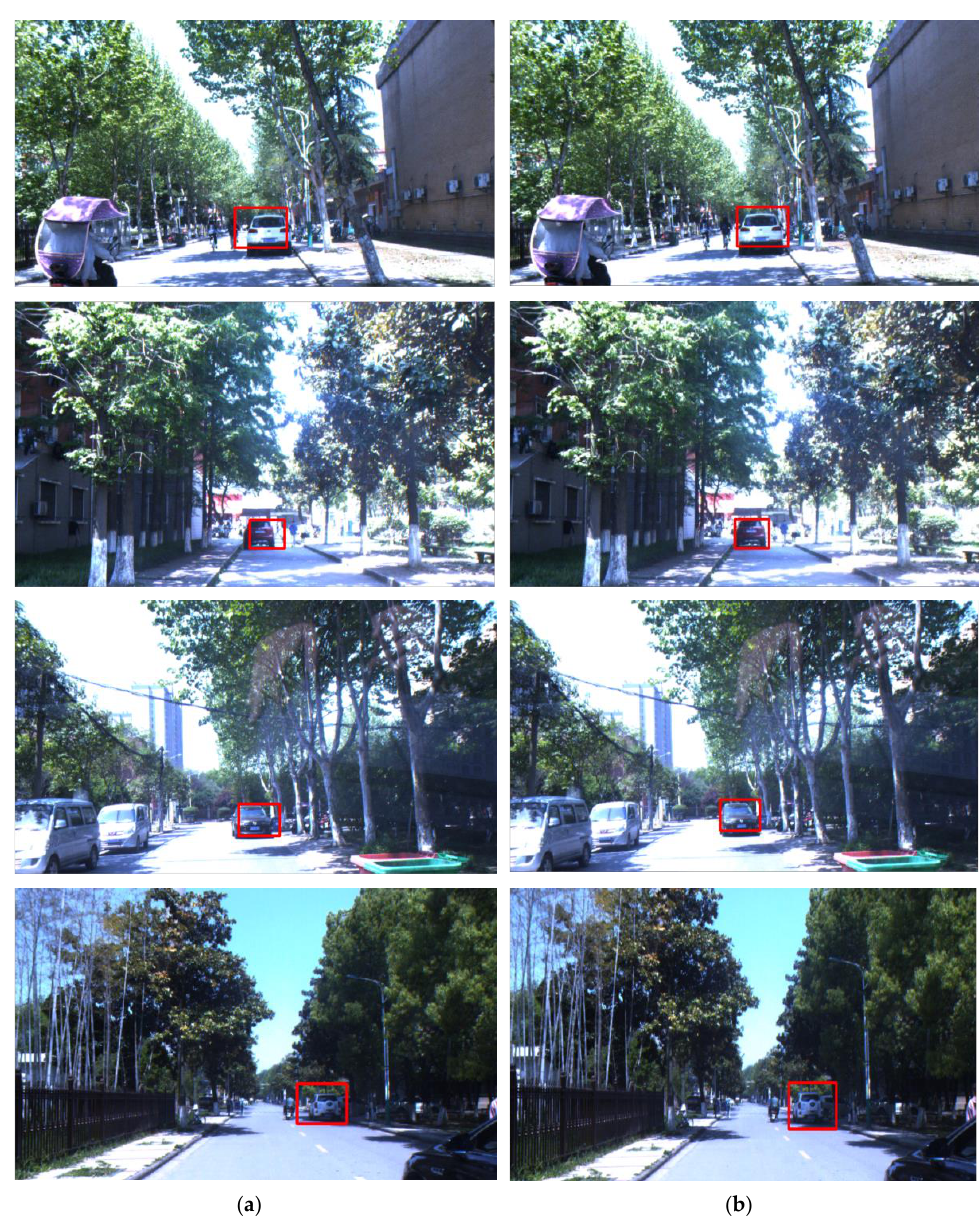
Figure 15. Comparison of vehicle recognition regions. ( a ) Initial radar identification region. ( b ) Identification region after improvement.